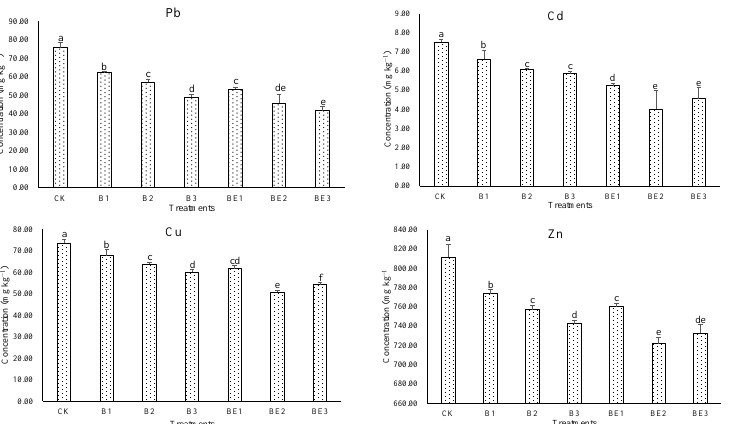
Figure 4. DTPA-extractable heavy metal concentrations in sludge for different treatments. Data are presented as the mean ± SD for three duplicates. Columns with different letters show a significant difference at p < 0.05 level.